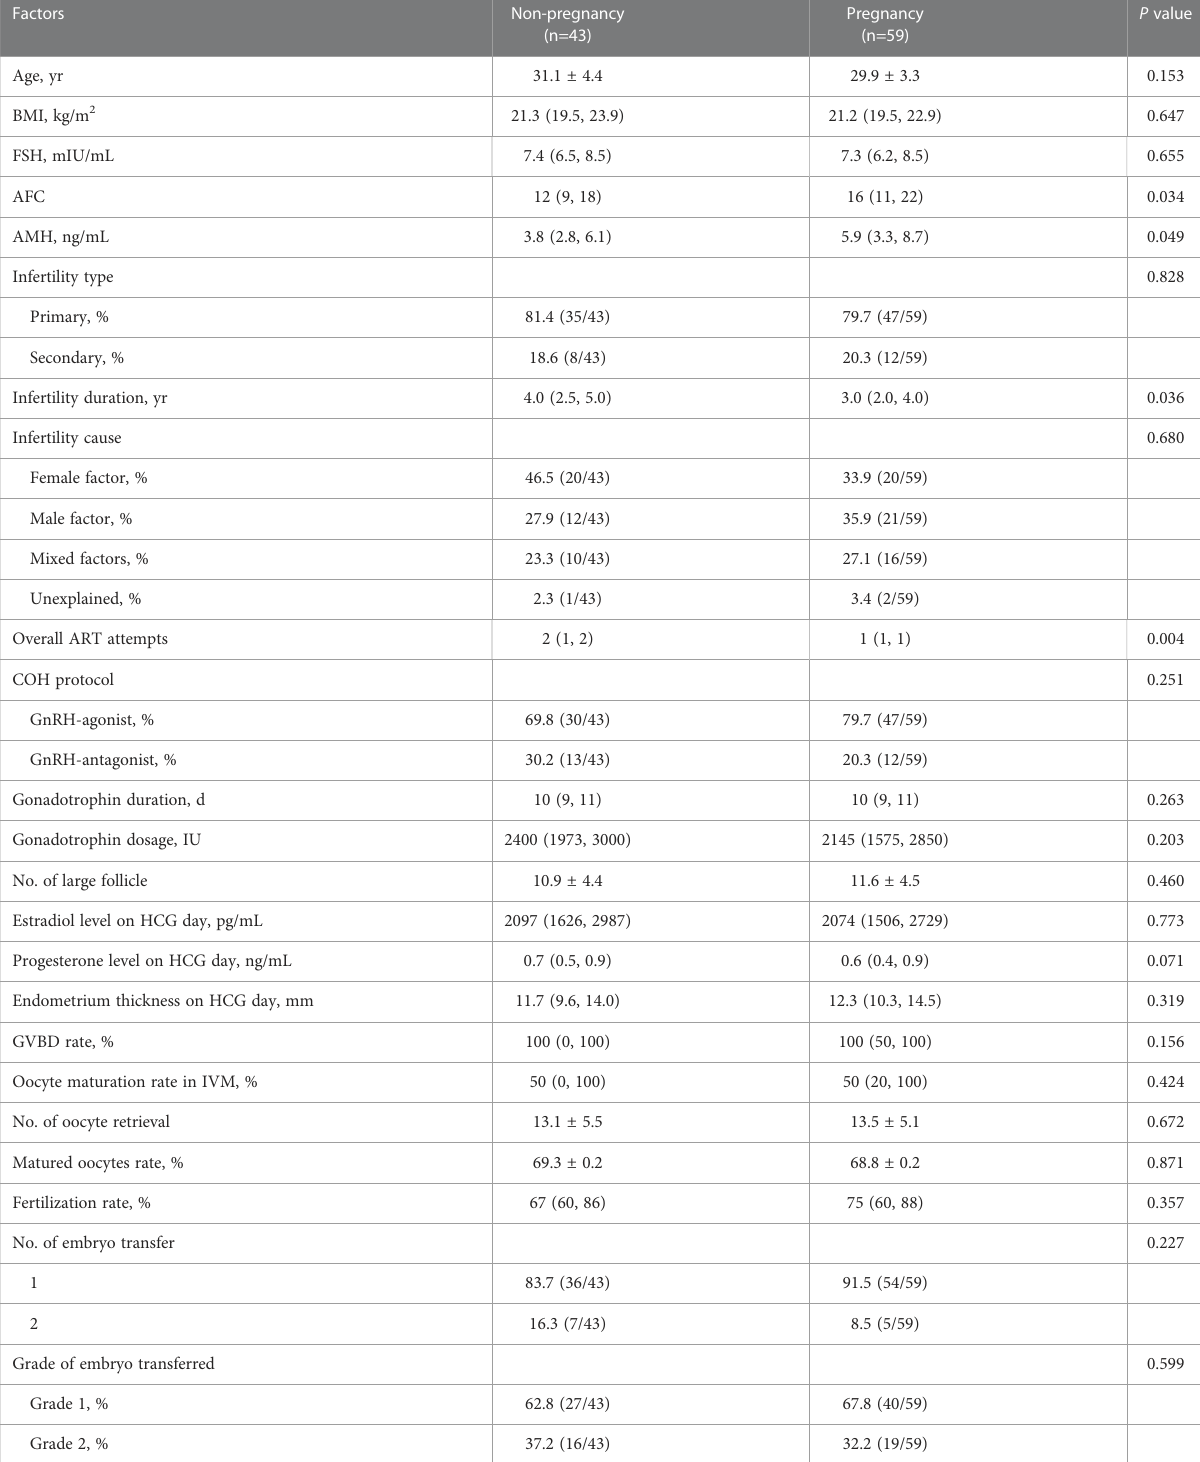
TABLE 1 Demographics and clinical characteristics of